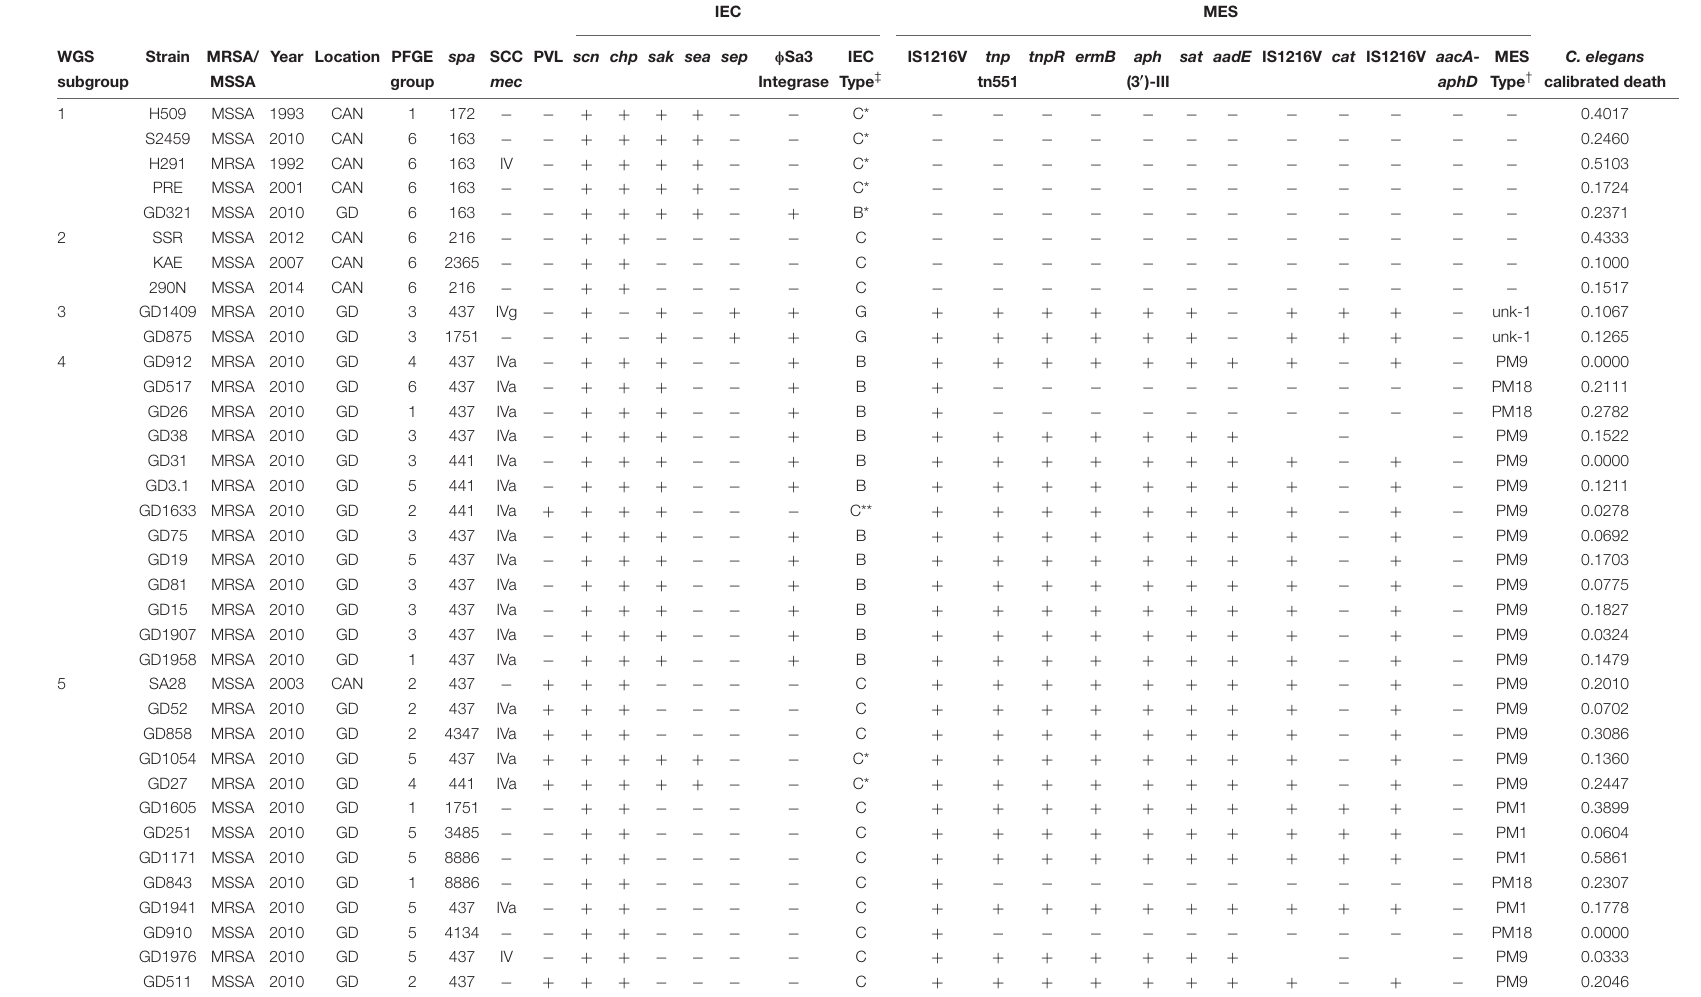
TABLE 1 | Summary of the 47 ST59 isolates selected for whole genome